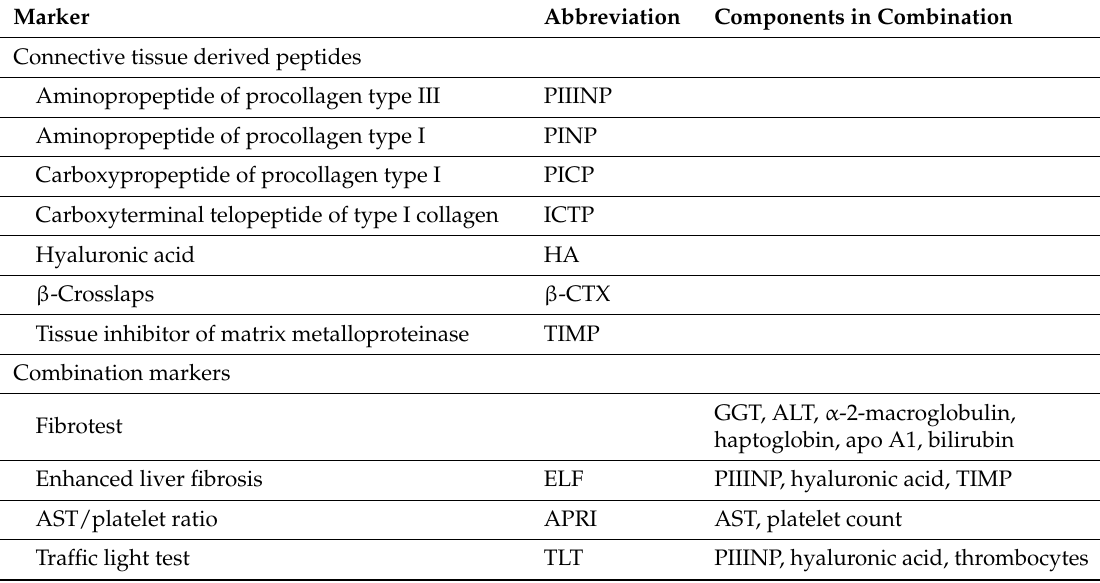
Table 4. Biomarkers of